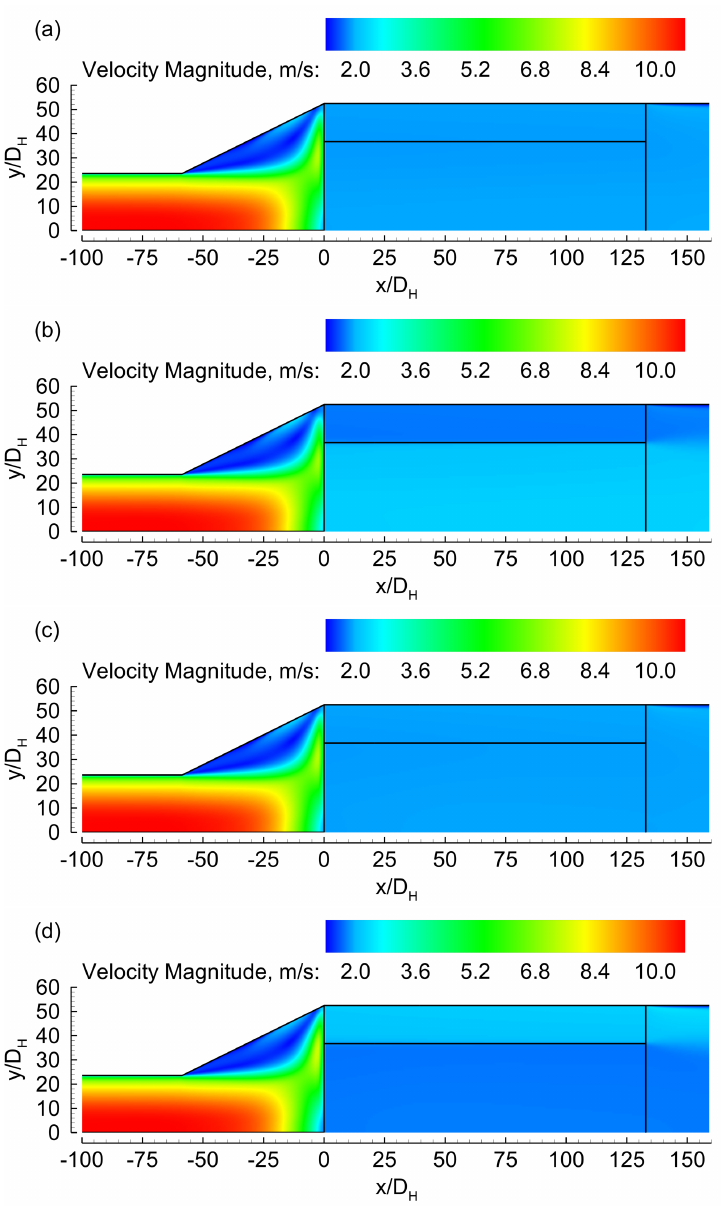
Figure 3. Flow distribution. ( a ) 400c/400r, ( b ) 400c/900r, ( c ) 900c/900r, and ( d )